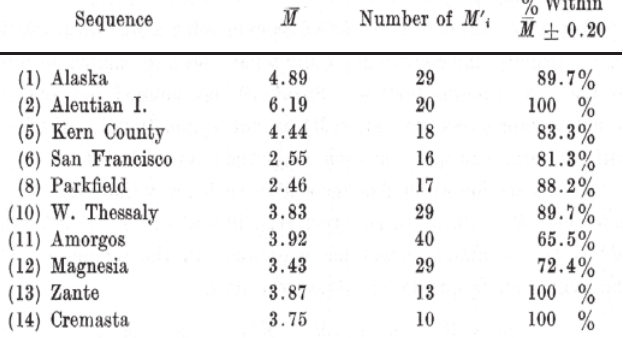
Table 7. Oscillations of mean magnitude.